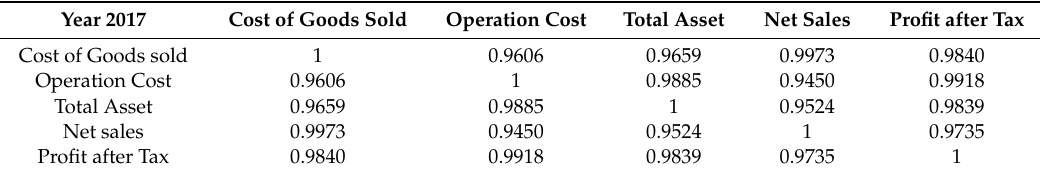
Table 1. Correlation between variables (2017).